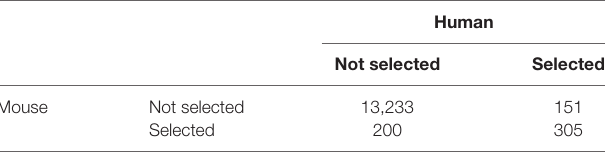
computed by Fisher’s exact test are 0 (i.e., less than numerical accuracy).